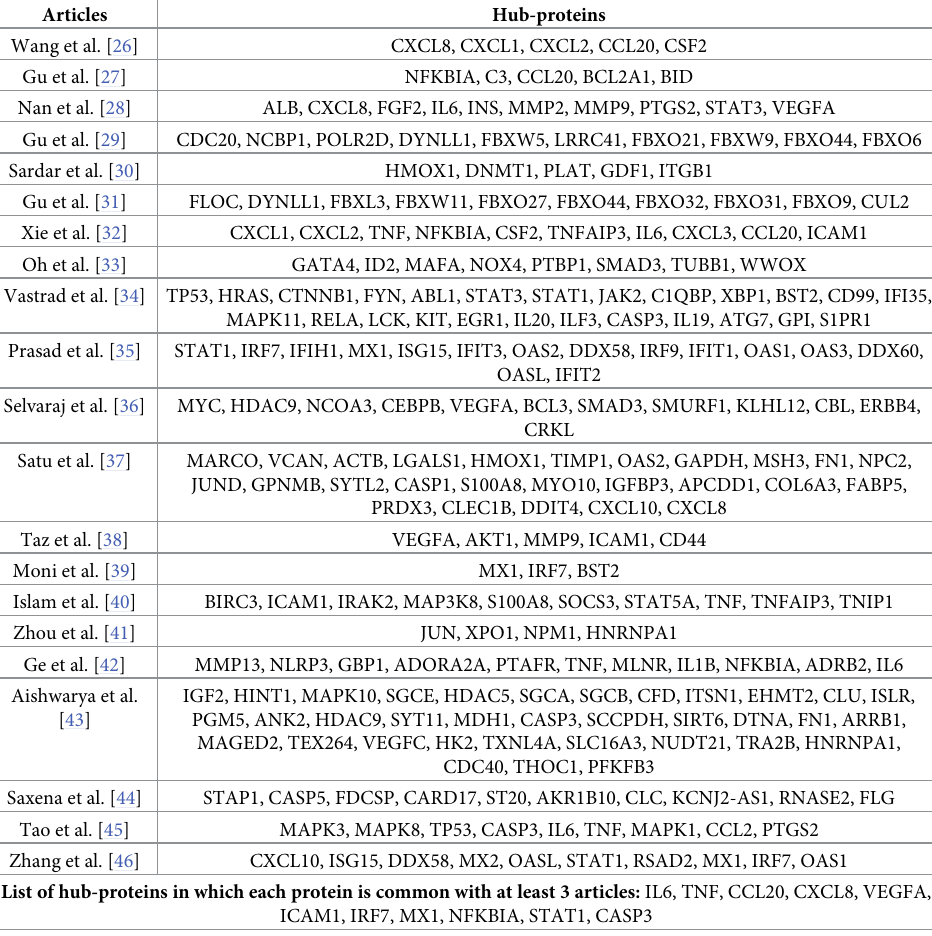
Table 2. Identification of top ranked target proteins associated with SARS-CoV-2 infections by literature